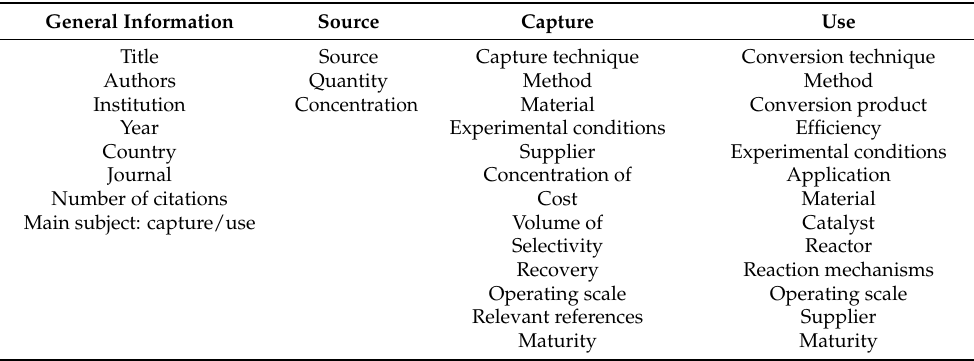
Figure 6. Distribution of selected reviews. Table 2. Topics selected for bibliometric analyses of scientific